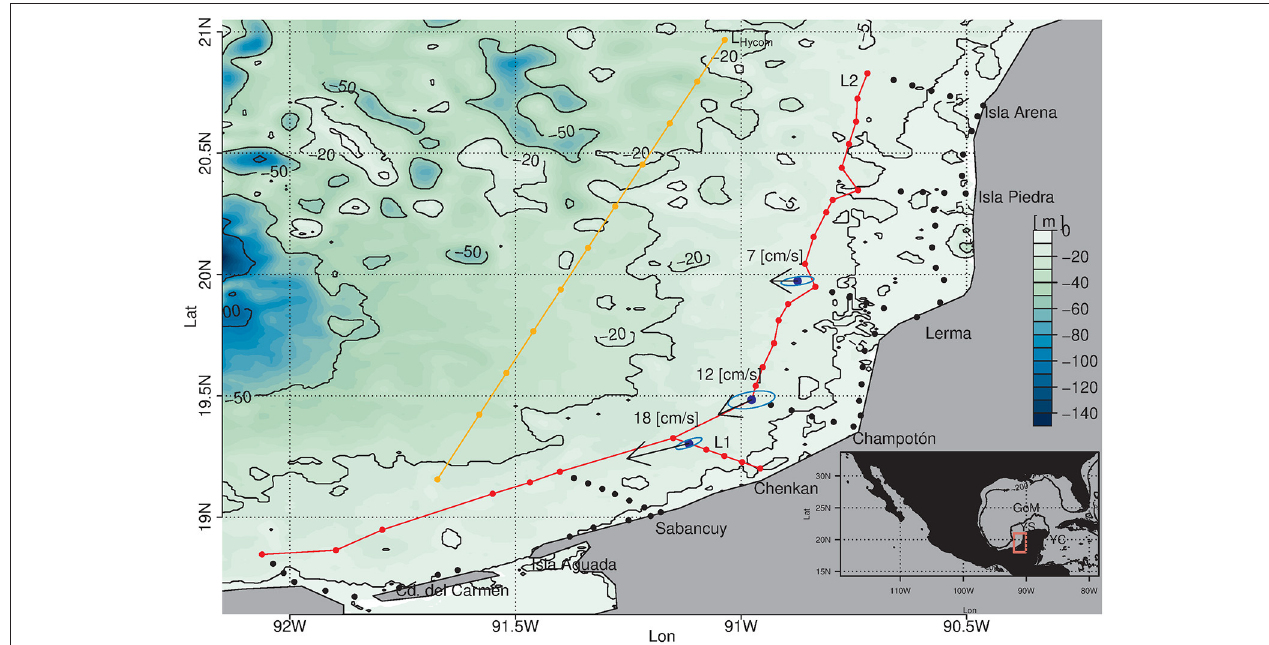
FIGURE 1 | Oceanographic surveys (black dots) and location of the acoustic Doppler current profilers (ADCPs) (blue dots). Red dots show stations used to depict cross-shore (L1) and along-shore (L2) views of the hydrographic properties. Mean surface current vectors and variance ellipses (in blue) during July 2018 are also shown. Orange dots depict the spatial location chosen to display the vertical distribution of the HYCOM model observations (LHycom). The background color is the bathymetry. GoM, Gulf of Mexico; YS, Yucatan Shelf; YC, Yucatan